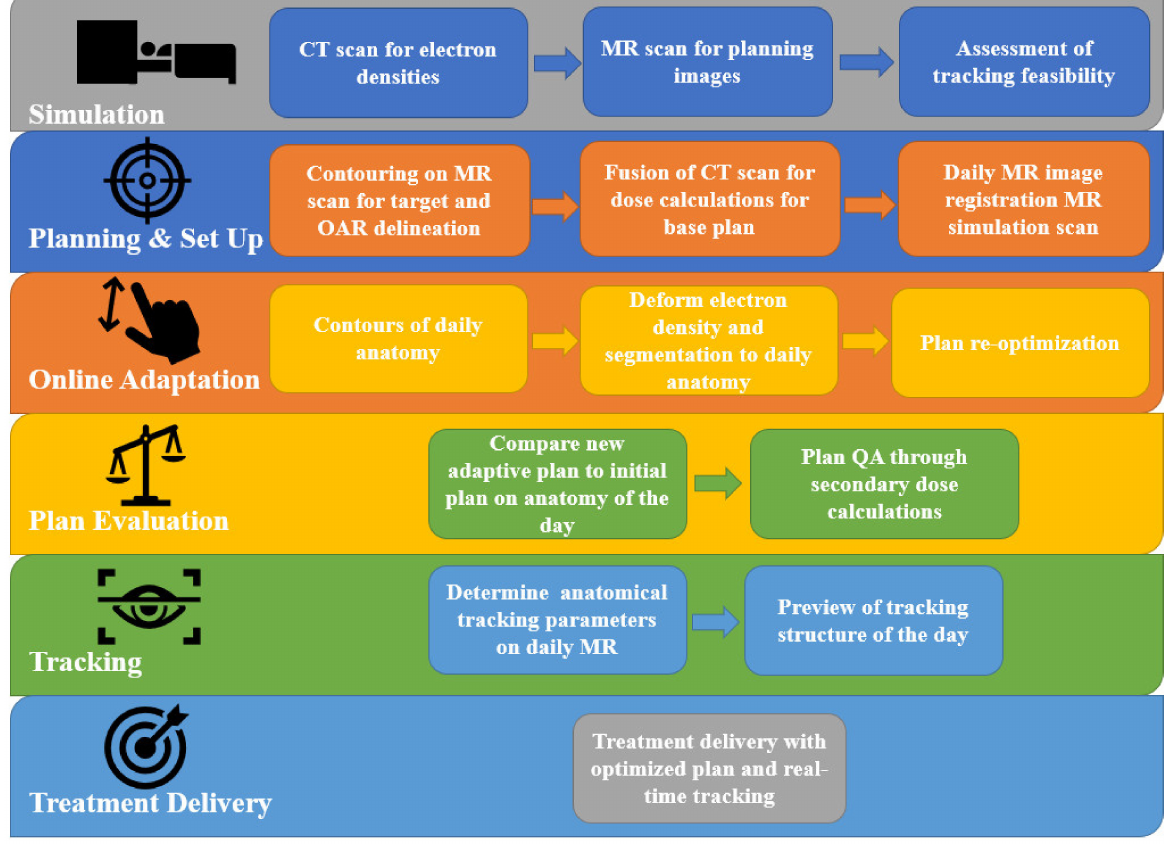
Figure 1. MRL workflow. CT: Computed tomography; MR: magnetic resonance; MRL: MR linear accelerator; OAR: organ at risk; QA: quality assurance. Table 1. Active SMART and nonadaptive MRL-SBRT clinical trials registered on ClinicTrials.gov. Both actively recruiting and active but not-yet-recruiting trials were